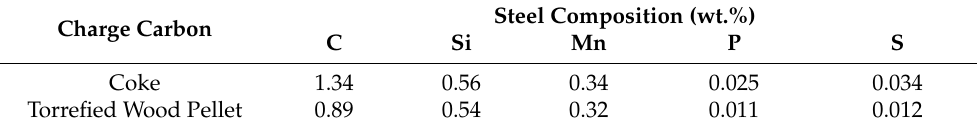
Table 7. Effect of torrefied wood pellets on steel composition.